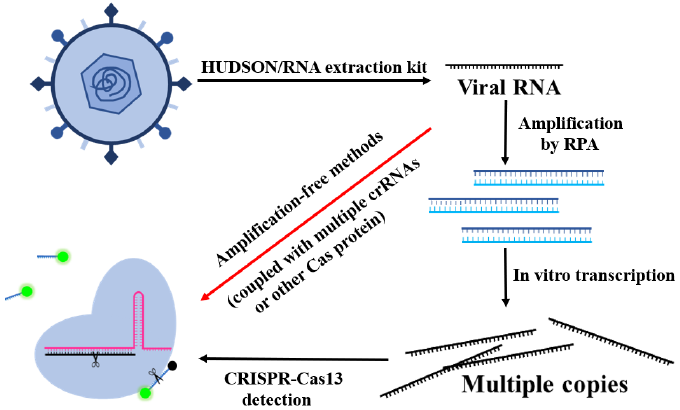
Figure 2. Strategies based on the CRISPR ‐ Cas system to detect SARS ‐ CoV ‐ 2.